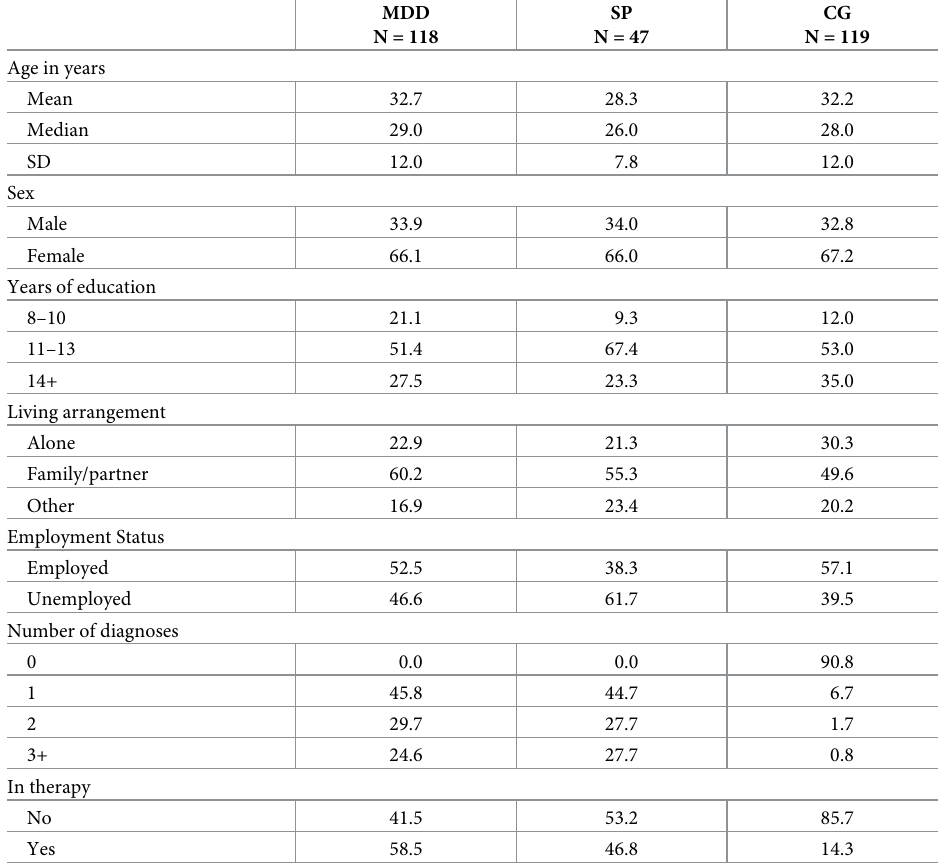
Table 1. Demographic information (%) and sample characteristics [mean and standard deviation